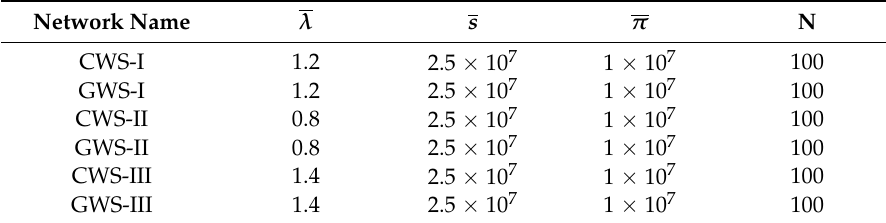
Table 4. Parameters of Simulation